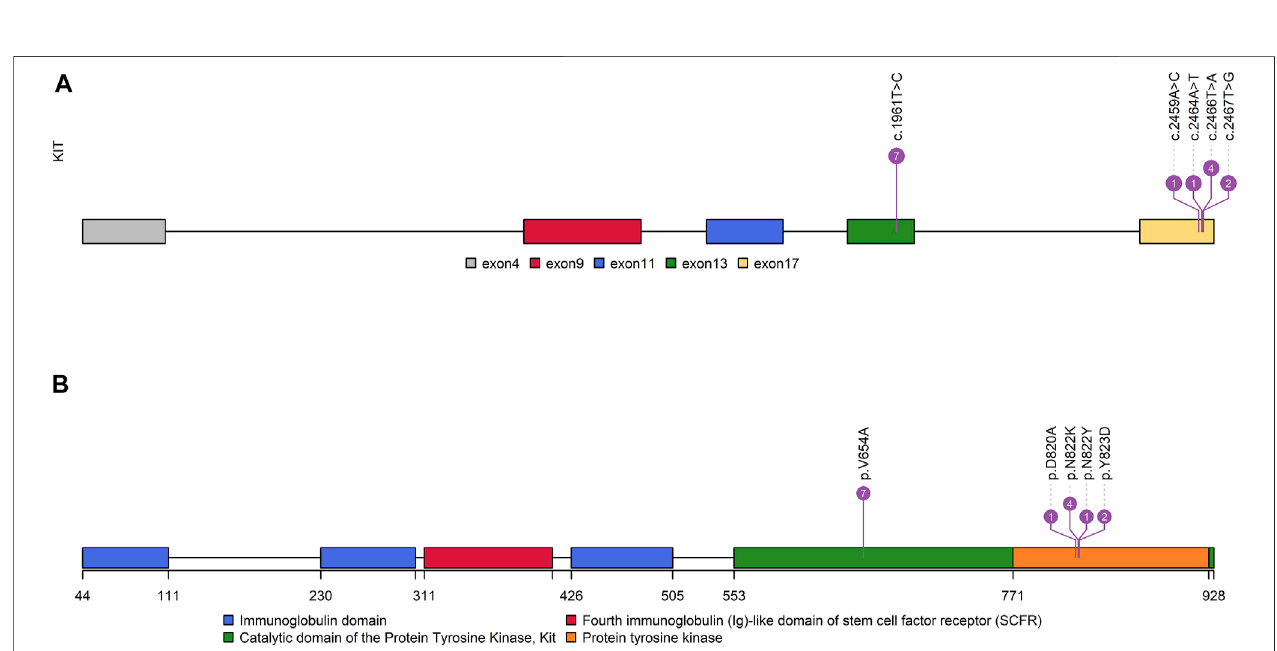
FIGURE 2 | Distribution characteristics of KIT -resistant mutations. (A) : Distribution of resistant mutations in the KIT gene. (B) : Distribution of resistant mutations in KIT functional domains.